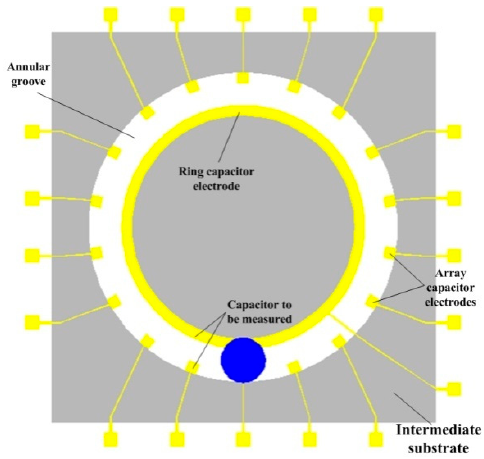
Figure 2. The schematic diagram of the array capacitor plates and the ring capacitor plate.